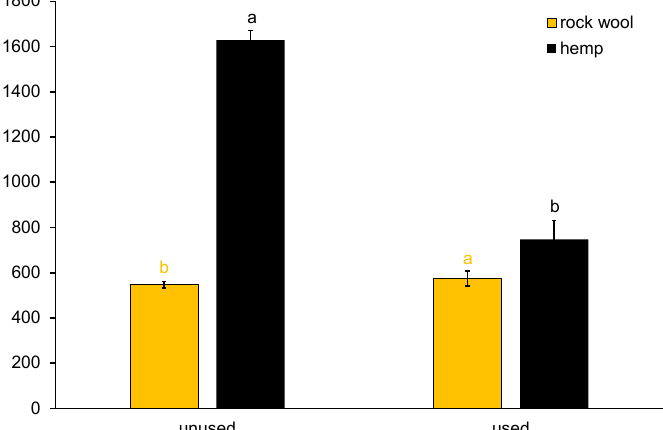
Figure 1. The mass of the substrates used as an indicator of the mineralized content of hemp and the increase in root biomass in rock wool in grams after 16 weeks of cultivation. Differences between unused and used substrates are indicated by different lowercase letters ( t ‐ test, p < 0.05, n = 3 for used substrates, n = 4 for unused hemp, n = 4 for unused rock wool, mean ± standard deviation).